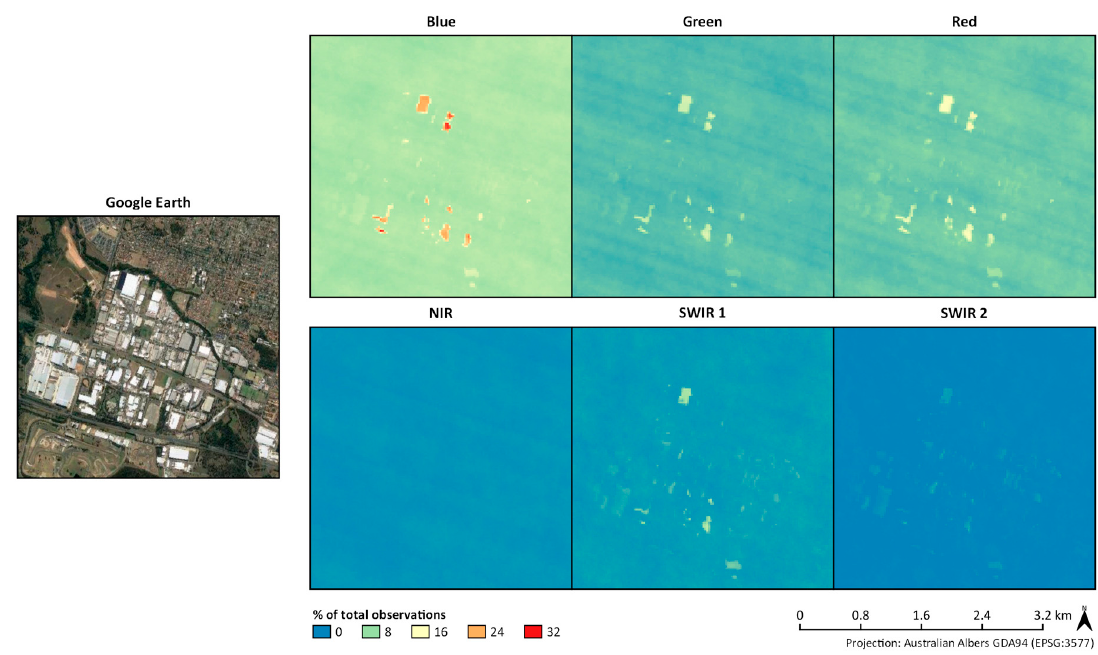
Figure 8. High-resolution imagery (Google), saturation flags in the visible, NIR, and SWIR bands in percent of total observations; Arndell Park/Huntingwood, Sydney, NSW.